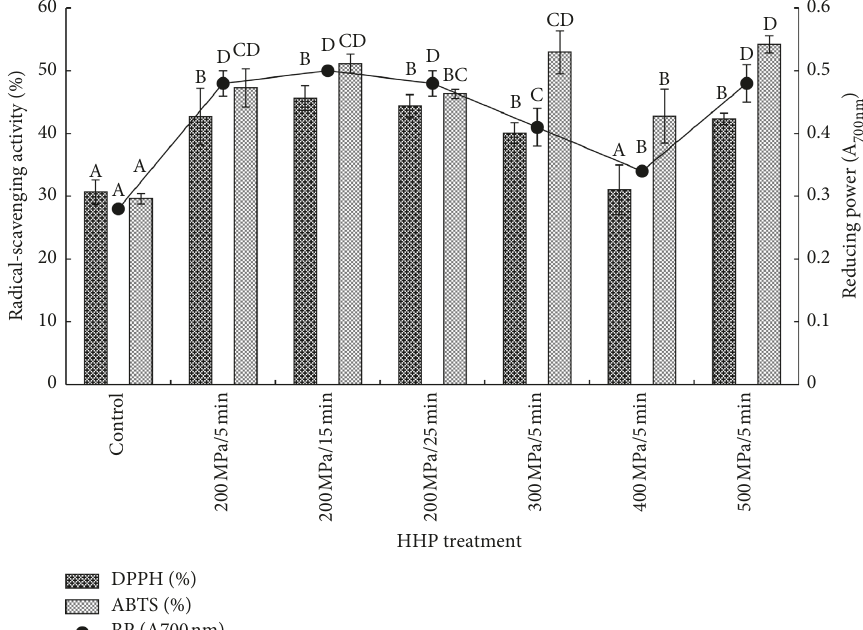
Figure 4: Antioxidant activities of melanoidins after different HHP treatments. Different uppercase letters in the same color bar and line indicate significant differences at the P < 0 . 05